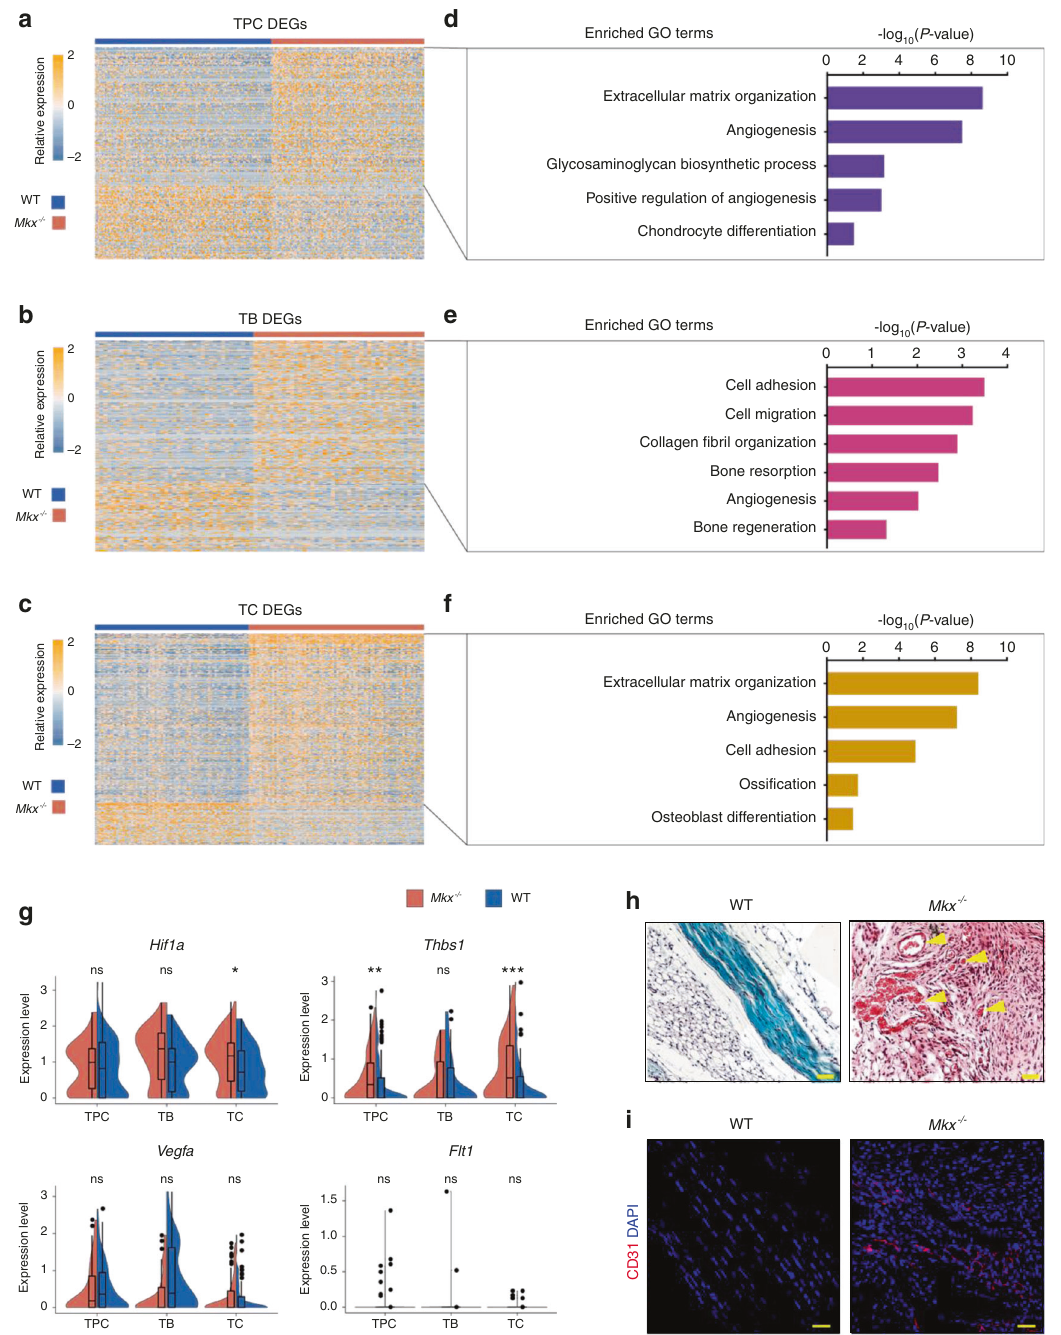
Fig. 5 Differential gene expression analysis revealed elevated angiogenic gene expression in Mkx − / − tendon cells. a – c Heatmap of the normalized gene expression of DEGs between WT and Mkx − / − TPC ( a ), TB ( b ) and TC ( c ) clusters. d – f Representative GO terms corresponding to upregulated genes in the Mkx − / − TPC ( d ), TB ( e ) and TC ( f ) clusters. g Violin plots of proangiogenic genes, including Hif1a, Thbs1, Vegfa , and Flt1 , in the TPC, TB and TC clusters. h Safranin O-Fast green staining of the patellar tendons from WT and Mkx − / − mice. The yellow arrows indicate the blood vessels. Scale bar, 50 μ m. i Immunostaining of CD31 in WT and Mkx − / − patellar tendons. Scale bar, 50 μ m. ns no signi fi cance; * P < 0.05; ** P < 0.01; *** P < 0.001. TPCs tendon progenitor cells, TBs tenoblasts, TCs